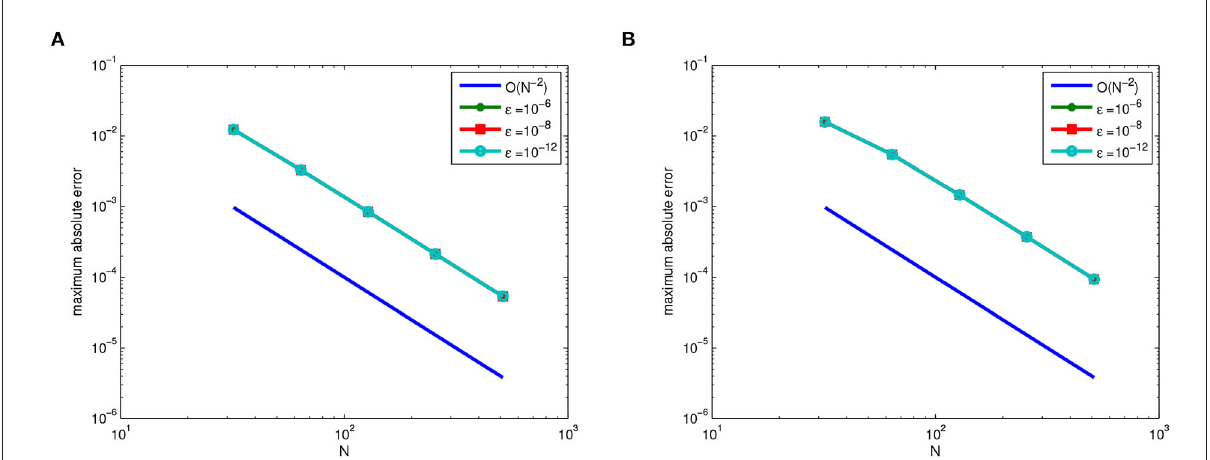
FIGURE3 The Log-Log plot of the maximum absolute error for different values of ε for Examples 1 and 2, respectively. (A) Log-Log plot for Example (1). (B) Log-Log plot for Example (2).